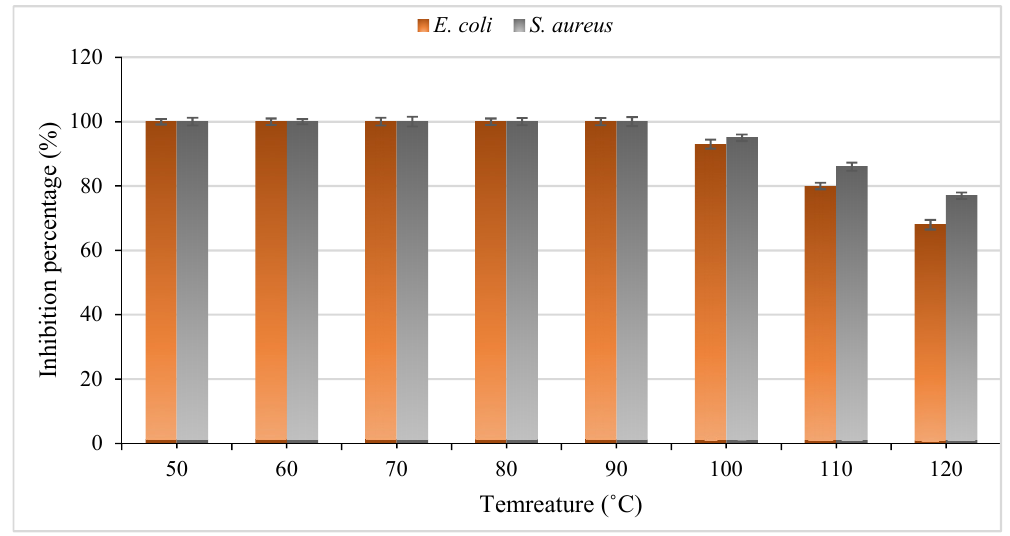
Figure 2. The thermal stability of the antibacterial peptide production from Saccharomyces cerevisiae .